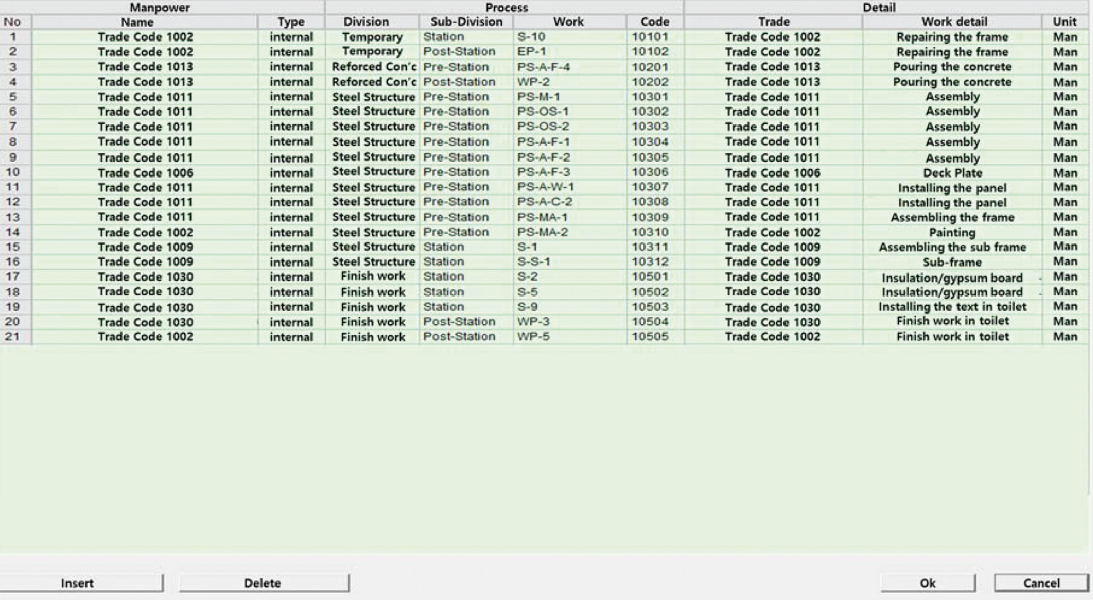
Figure 8: Manpower breakdown